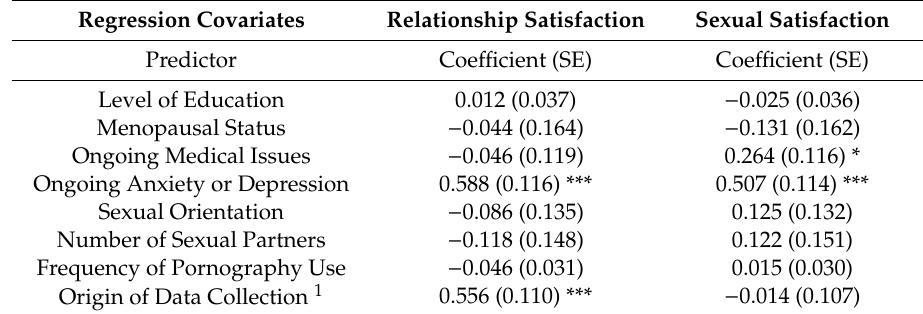
Table 5. Ordered logistic regression results for predicting overall relationship satisfaction and sexual relationship